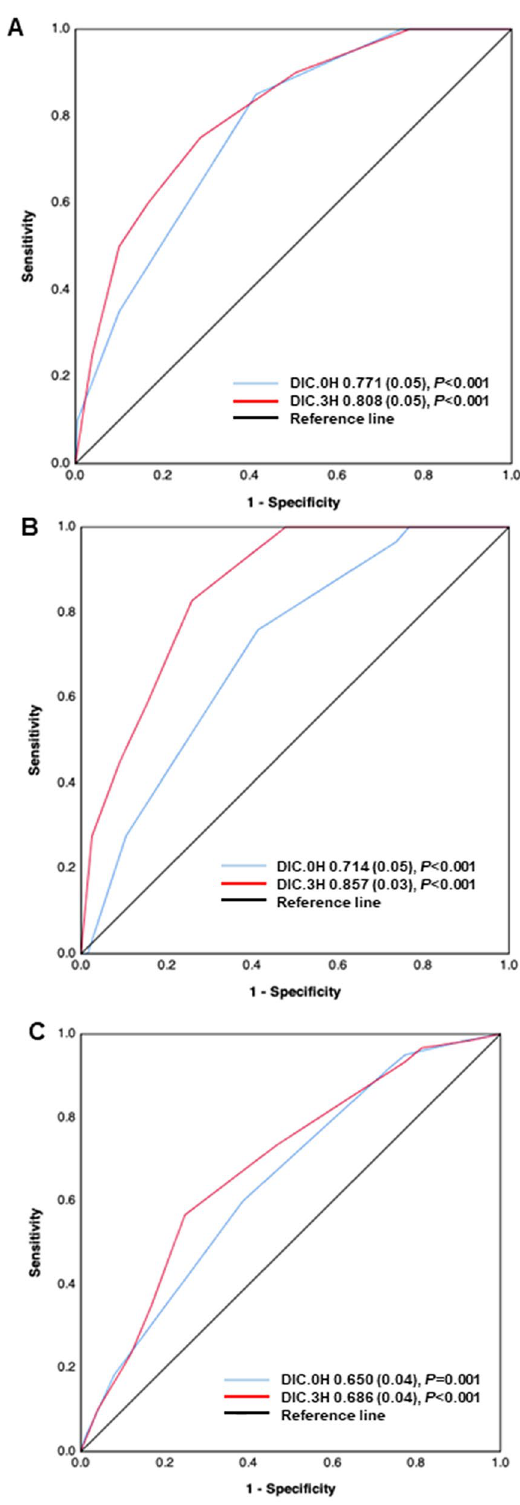
Figure 2. Receiver operating characteristic (ROC) curves of disseminated intravascular coagulation (DIC) scores at 0 and 3 h after presentation to the emergency department (ED) to predict hospital death ( A ), massive transfusion ( B ), and multiple organ dysfunction syndrome (MODS) ( C ) at 24 h after presentation to the ED. The number indicates the area under the ROC curve (AUC) (standard